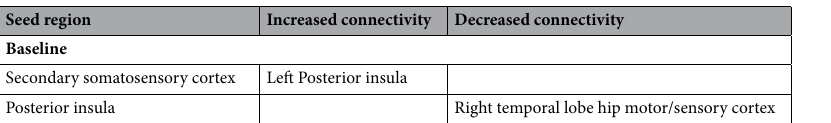
Table 2. Seed regions and connectivity comparisons between OA patients and controls pre